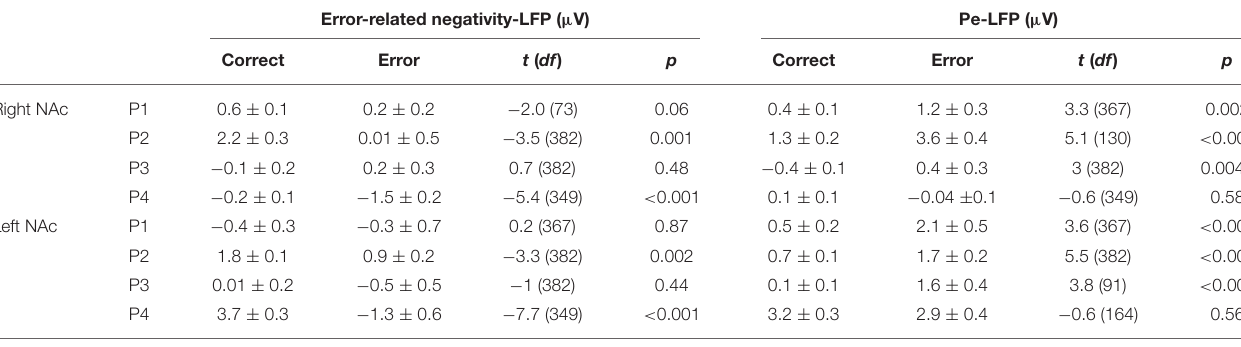
TABLE 3 | Amplitude measures of local field potentials (LFPs) in the right and the left NAc.